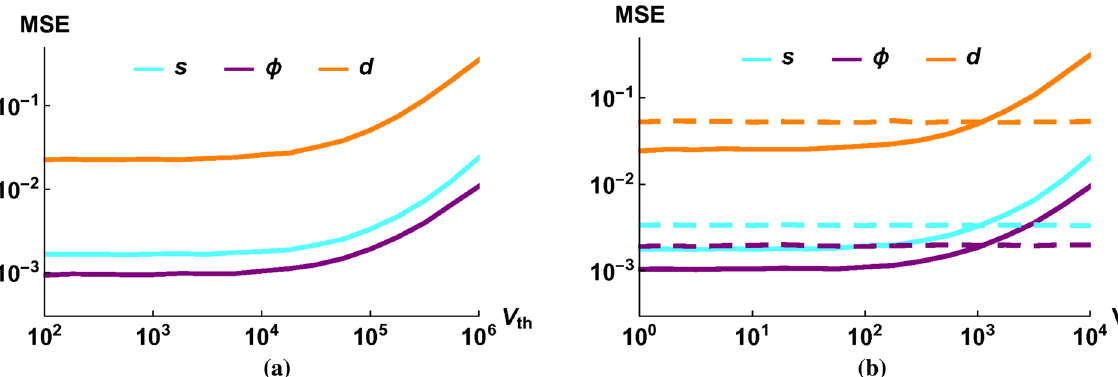
Figure 4. The MSE of the estimators of the Gaussian process as a function of ( a ) the thermal bath variance ( V th ), ( b ) the initial variance of the mechanical mode ( V ). The purple (dark) lines correspond to the phase shift, the orange (medium) lines correspond to the magnitude of the displacement and the cyan (light) lines correspond to the magnitude of the squeezing. We have plotted for ( b ) original algorithm (solid lines) and 3 10 5 , r 10 2 , K 0.03 , T 0.99 , 1 10 η corrected algorithm (dotted lines). The parameters are N , − = = = = − = 0.03 , d 0.05 , β 1.02 , α 0.6 , ( a ) V 10 , ( b ) V th 0.4 , s V GP 10 4 (cid:31) = = = = − = = = =